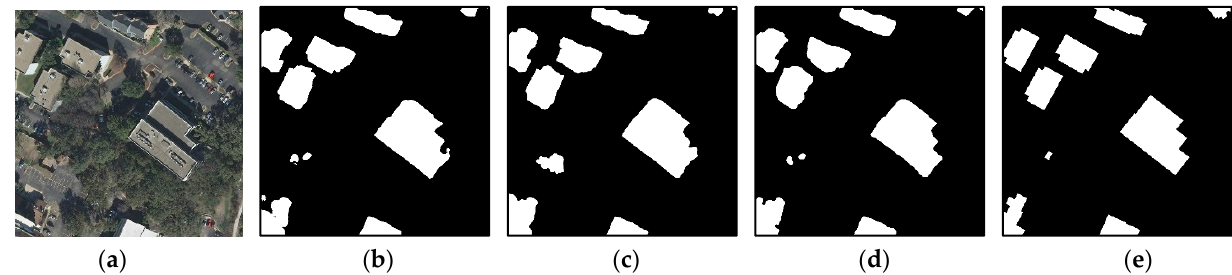
Figure 9. Visual comparisons of building-extraction results on the Inria Aerial Image Labeling data set by different models. ( a ) Input image, ( b ) UNet, ( c ) Deeplabv3+, ( d ) the proposed DMBC-Net, and ( e ) ground truths of the input image.